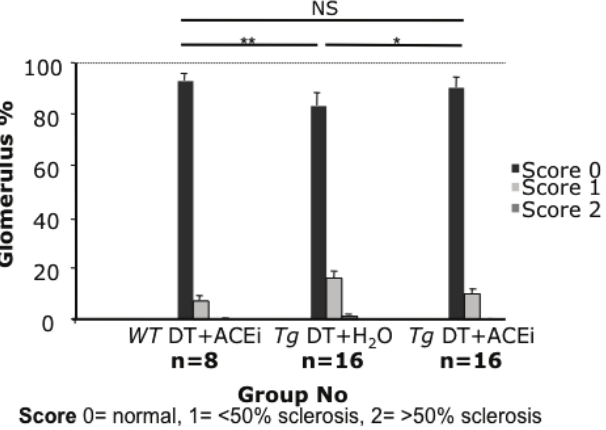
Figure 6. Glomerulosclerosis score of Podo-DTR line 57 mice at 8 weeks post DT injection at 5ng/g bw +/- captopril (200mg/L). Glomerular scarring was reduced almost to baseline level by ACEi captopril ( Tg DT+H O: 17%, Tg DT+ACEi: 10%, p<0.04; wild-type 2 control: 7%).